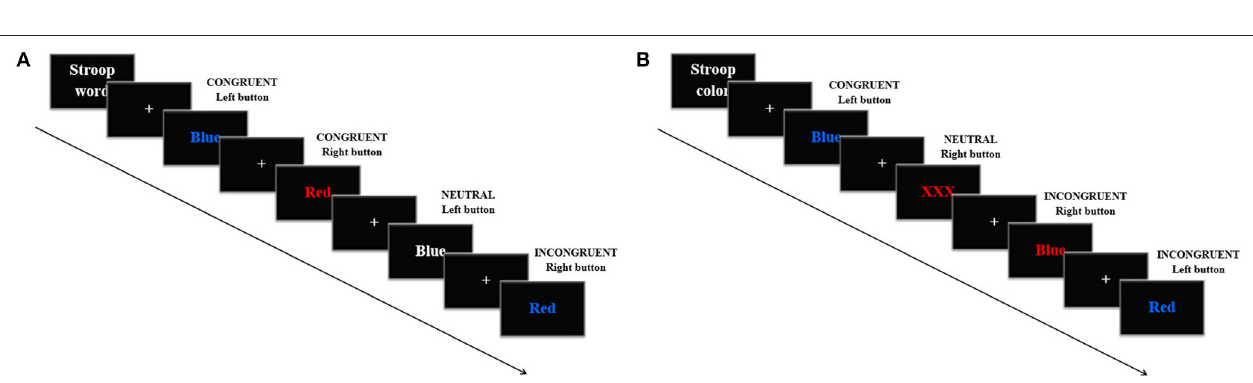
FIGURE 1 | Example of four trials in the N-back task. Every trial appeared every 2s and lasted 1s each. Participants were instructed to press left mouse button when “yes” and the right one if “no.” For 0-back (A) , targets were letter X; for 1-back (B) , the target was when the letter matched the previous letter; and for 2-back (C) and 3-back (D) when it was identical to the one presented 2 or 3 trials before, respectively.